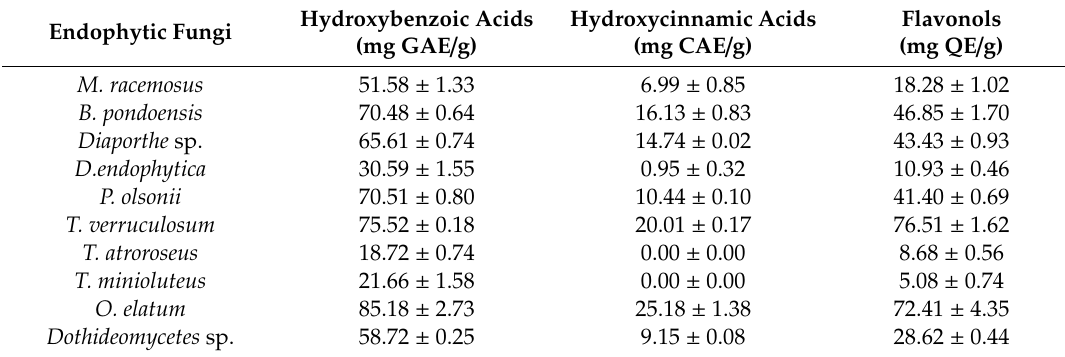
Table 3. Phenolic compounds of the extracts of the endophytic fungi isolated from S. terebinthifolius with a frequency of colonization above